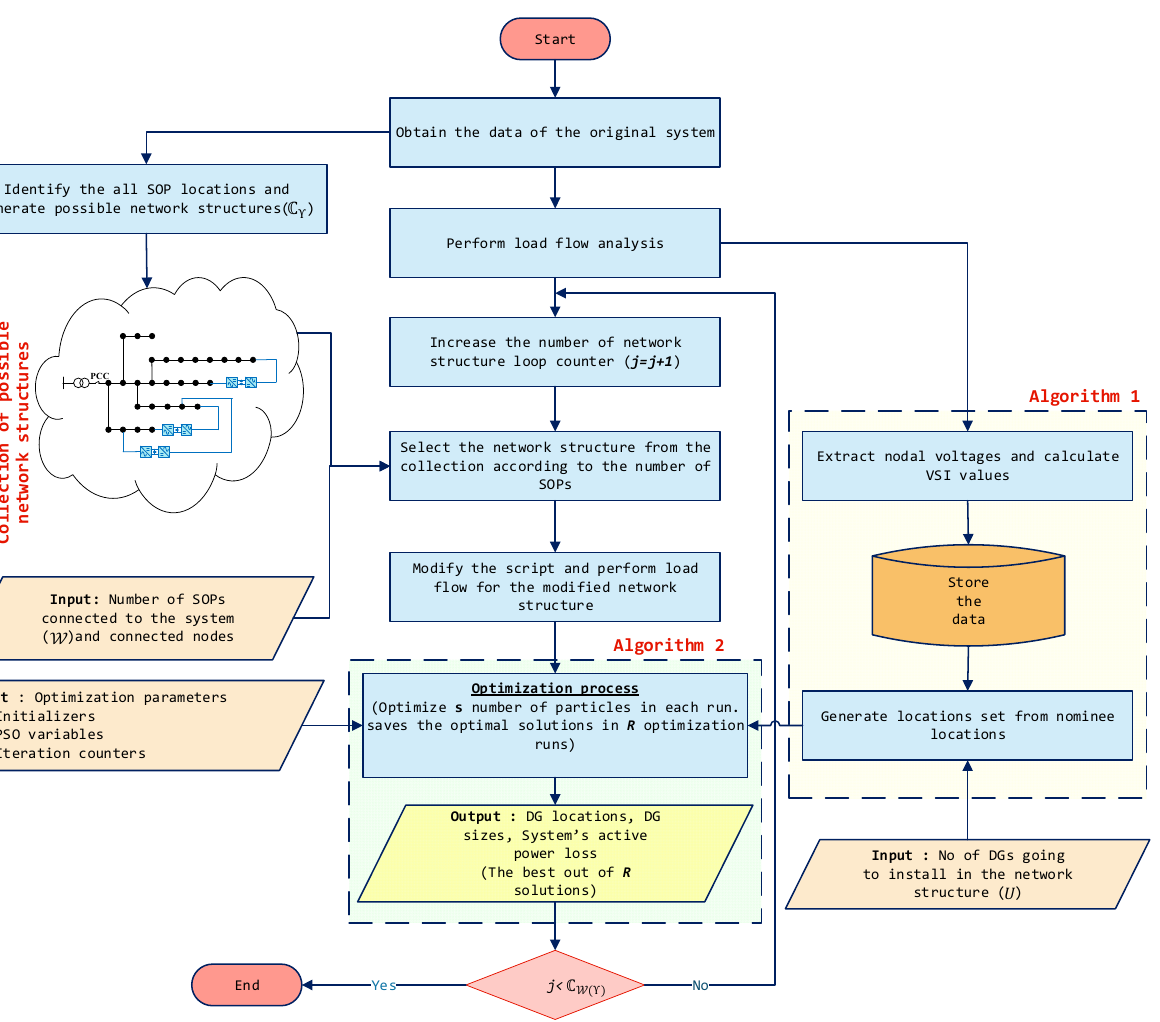
Figure 6. Flow chart of the generalized methodology.